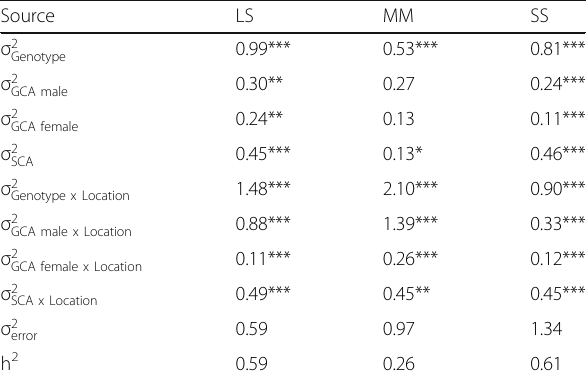
Table 1 Second degree statistics for hybrid grain yield (Mg ha − 1 ) experiments in market segments LS, MM, and SS performed in three, two, and four environments, respectively Source